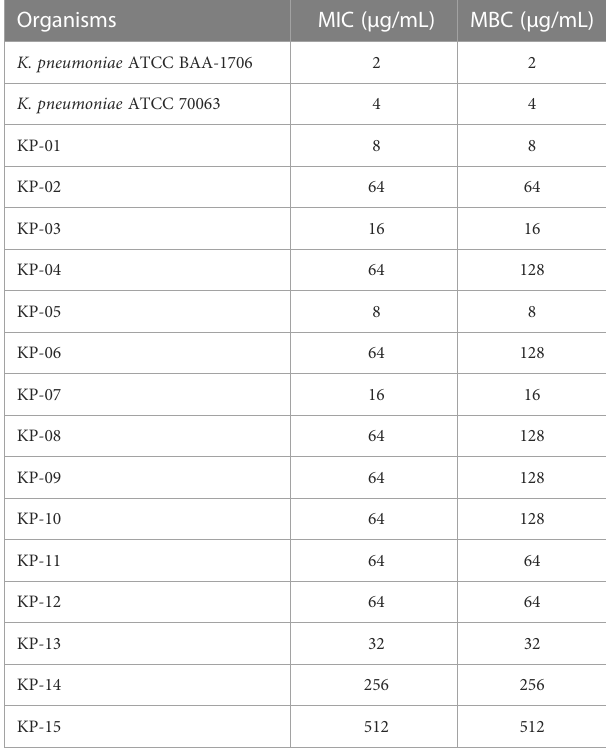
TABLE 1 The MIC and MBC values of K11 against K. pneumoniae reference strains and MDR/XDR K. pneumoniae clinical isolates.